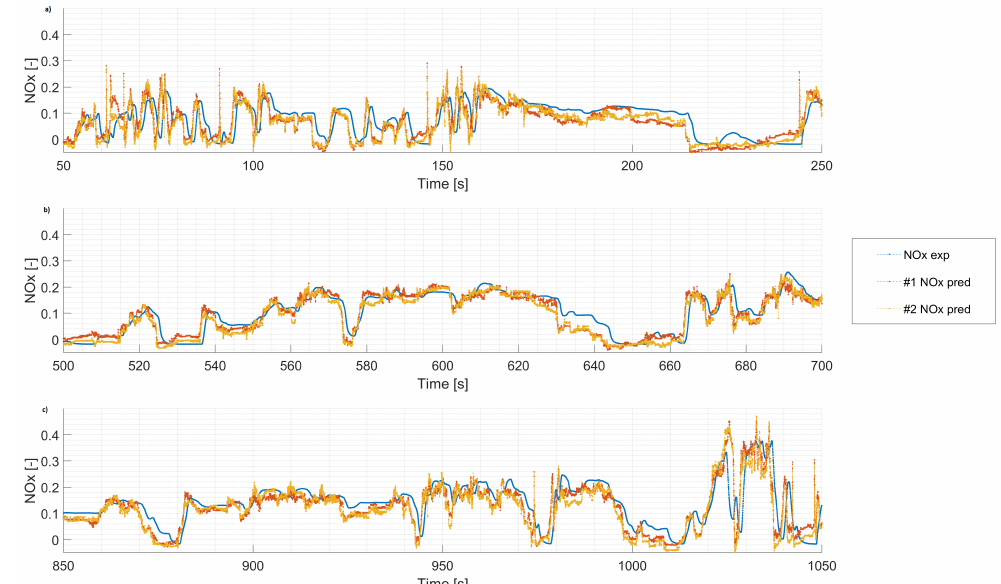
Figure 7. The NOx predicted signals for cases study #1 and #2. ( a – c ) depict three distinct 200 s-length windows of driving